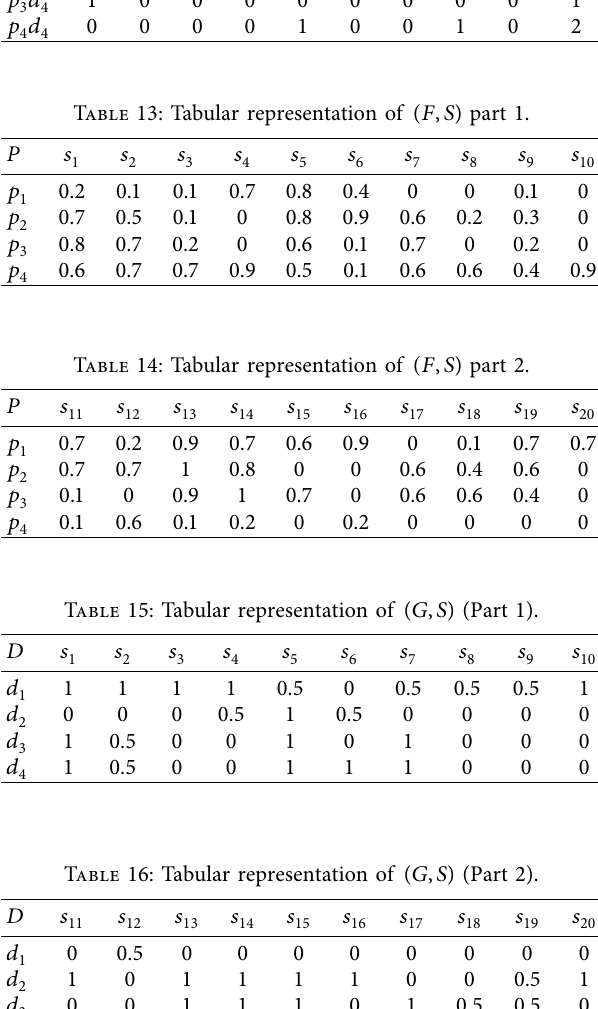
Table 20: Tabular representation of ( F